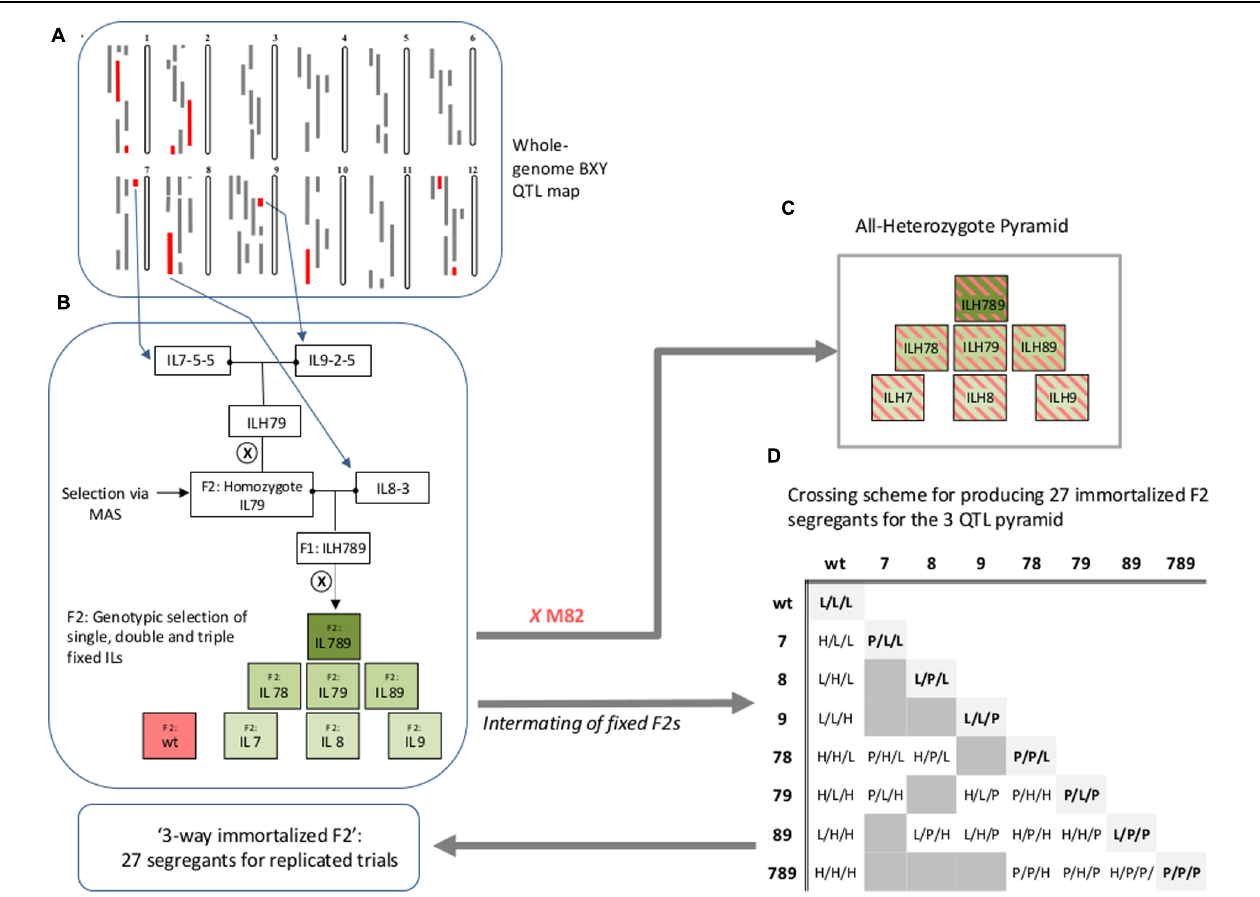
FIGURE 1 | Workflow for creation of IL789 pyramids and the ‘3-way Immortalized F2.’ (A) BXY quantitative trait loci (QTL) map (Gur et al., 2011) used as the basis for selection of target IL-QTLs for pyramiding. The 12 tomato chromosomes are shown. Gray bars on the left of each chromosome are positions of introgressions at each of the Solanum pennellii ILs (Eshed and Zamir, 1995, http://solgenomics . net/). Red bars are introgression lines that showed significant increase in BXY compared to M82. (B) Description of the workflow for creation of the different QTL stacks. (C) The ‘All-Heterozygote’ pyramid, composed of single, double and triple introgression lines that were backcrossed to M82; all introgressions are present at the heterozygote state (ILH; IL-Hybrid). (D) Crossing scheme for producing 27 immortalized F2 segregants for the three QTL pyramid. Single, double and triple homozygote ILs were intermated to create the ‘3-way immortalized F2’. The numbers (7, 8, or 9) indicate the chromosome number and refer to the presence in homozygote state of S. pennellii introgressions IL7-5-5, IL8-3, and IL9-2-5, respectively. For the 27 genotypes at the ‘immortalized F2’ table; L = homozygote lycopersicum , H = Heterozygote, P = homozygote pennellii . Genotypes are expressed in the following order: